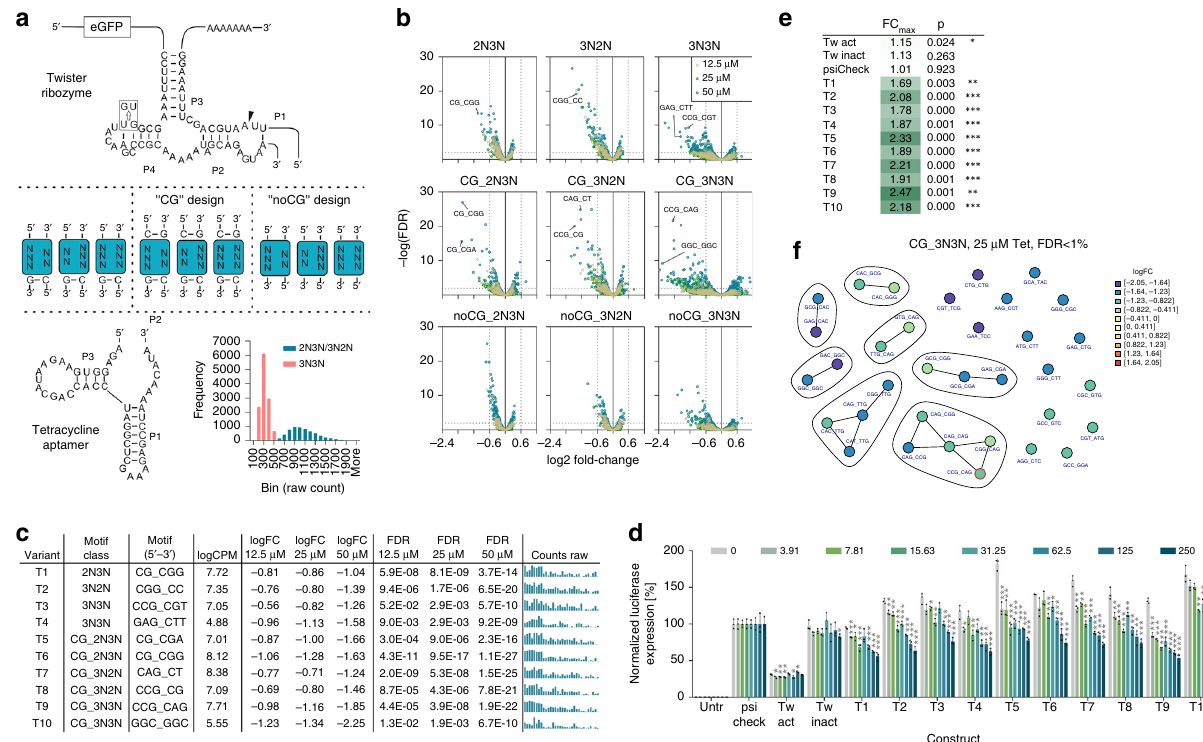
Fig. 5 Identi fi cation of Tet-responsive Twister ribozymes by amplicon-seq. a Secondary structure of the Tet-Twister library design. Blue boxes indicate the randomized motifs of the nine sub-libraries, connecting the Twister ribozyme and the Tet aptamer. The arrowhead indicates the cleavage site. GU/UG mutation at the indicated position renders the ribozyme inactive. Inset: Library construct frequency analysis by DNA sequencing. b Volcano plots displaying the signi fi cance (FDR) of changes in riboswitch abundance as a function of the change in expression (log 2 fold change) for the nine Tet-Twister sub- libraries. Selected hits are labeled with their sequence motif. c Selected hits from the Tet-Twister library screen, randomized sequence, mean counts per million (CPM), fold change (FC) and false-discovery rate (FDR) at 12.5, 25, and 50 µ M Tet, respectively. The bar plots show the raw counts under untreated, 12.5, 25, and 50 µ M Tet-stimulated conditions (four groups from left to right, n = 8 replicates each). d Functional hit validation in HeLa cells at increasing tetracycline doses [ µ M] ( n = 3 replicates, mean ± s.d.); psi-Check: ribozyme-free control construct; Tw-act/inact: constitutively active/inactive ribozyme control. e Maximal fold changes and p -values measured upon stimulation vs. 0 µ M Tet for all tested constructs. f Network analysis of motif similarity for the CG_3N3N library at 25 µ M Tet vs. untreated and an FDR < 1%. Each line segment represents a single nucleotide change. The “ T9 ” construct is circled in red. * p < 0.05, ** p < 0.01, *** p < 0.001 (unpaired T -Test, two-tailed). Source data are provided as a Source Data fi